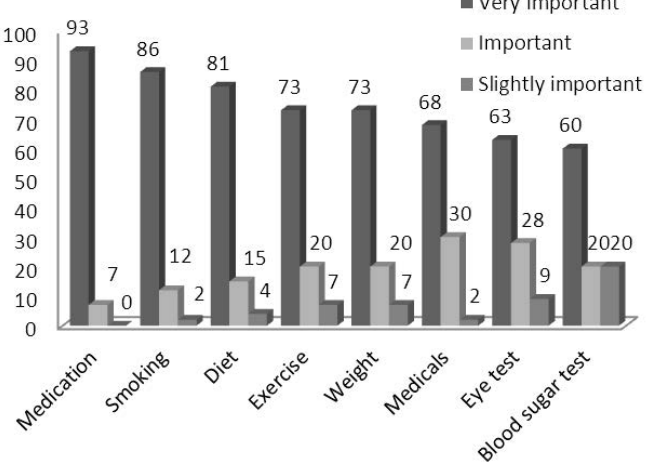
Figure 2: Patients importance ratings of factors that are involved in the management of DM.